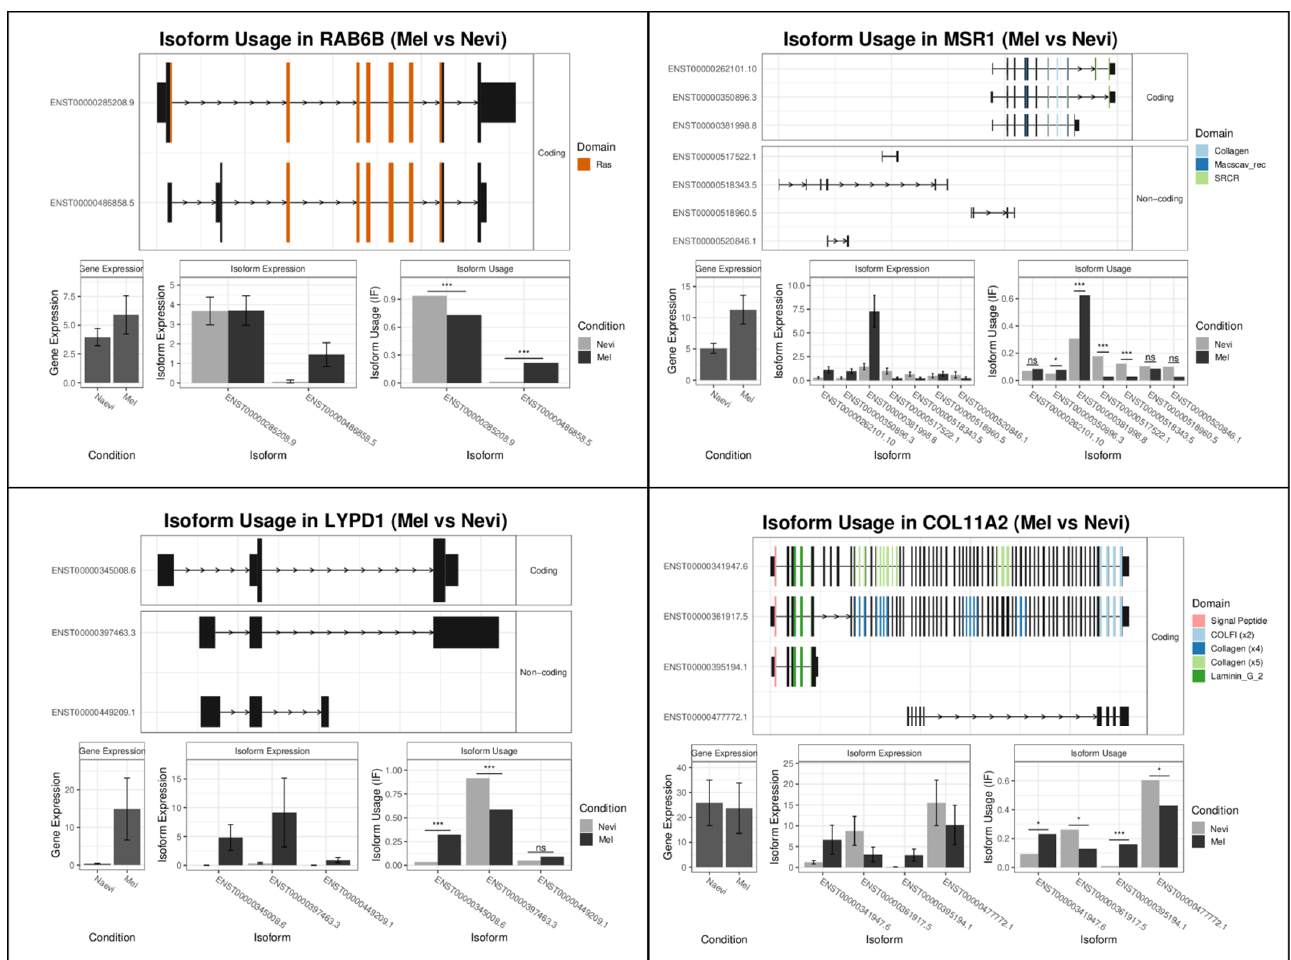
Figure 2. Top spliced genes in melanoma as compared to benign melanocytic nevi. A set of 80 melanoma and benign nevus samples was analyzed by RNA-seq technology after laser microdissection of melanocytic cells. Differential gene expression analysis was performed as described in the Materials and Methods section. For the identification of differentially expressed splice variants, the kallisto program was used. Splice variants of 4 from the top 10 spliced genes are shown. SRCR, Scavenger receptor cysteine-rich protein domain; Macscav_rec, Macrophage scavenger receptor. For each gene, the structures of the switched isoforms are shown, as well as gene and isoform expression and usage. *, p < 0.05; ***, p < 0.001; n.s., not significant.